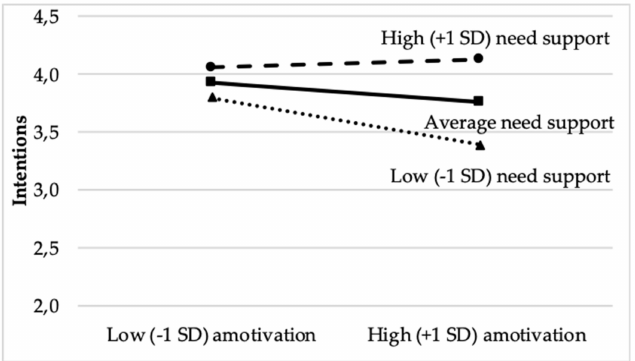
Figure 1. The relation between amotivation and intentions to undertake extracurricular PA as a function of class-level perceived need